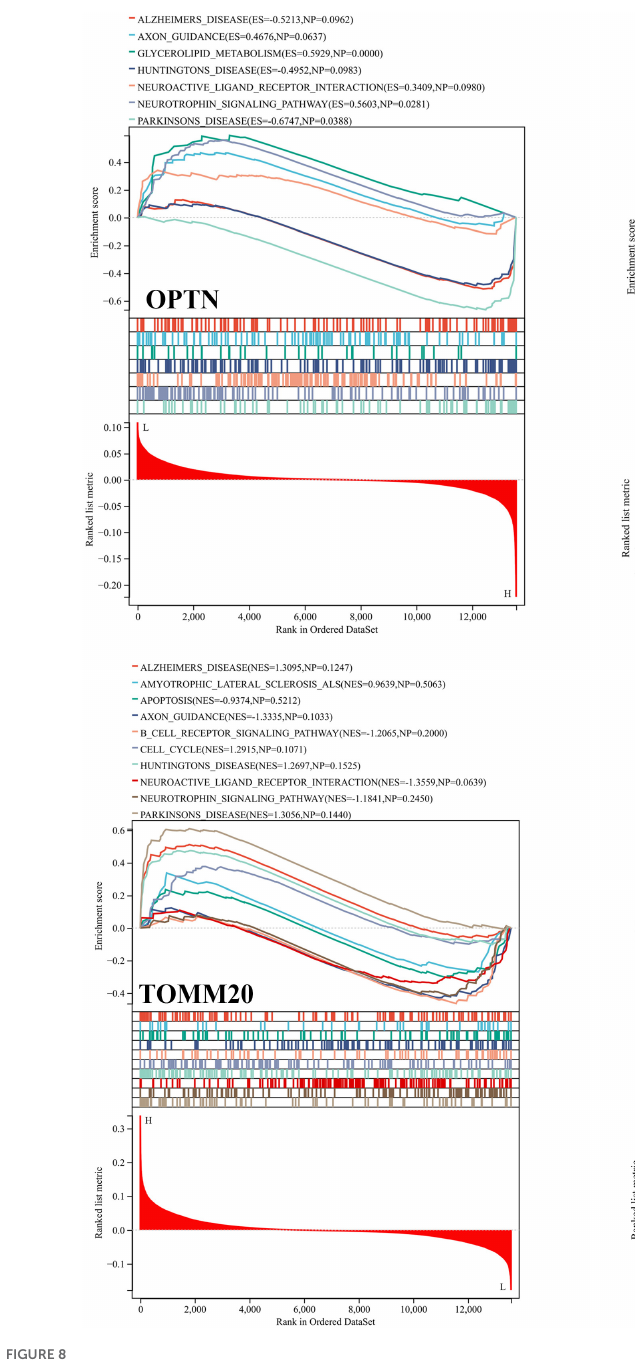
and predictive model, and to verify and evaluate the accuracy